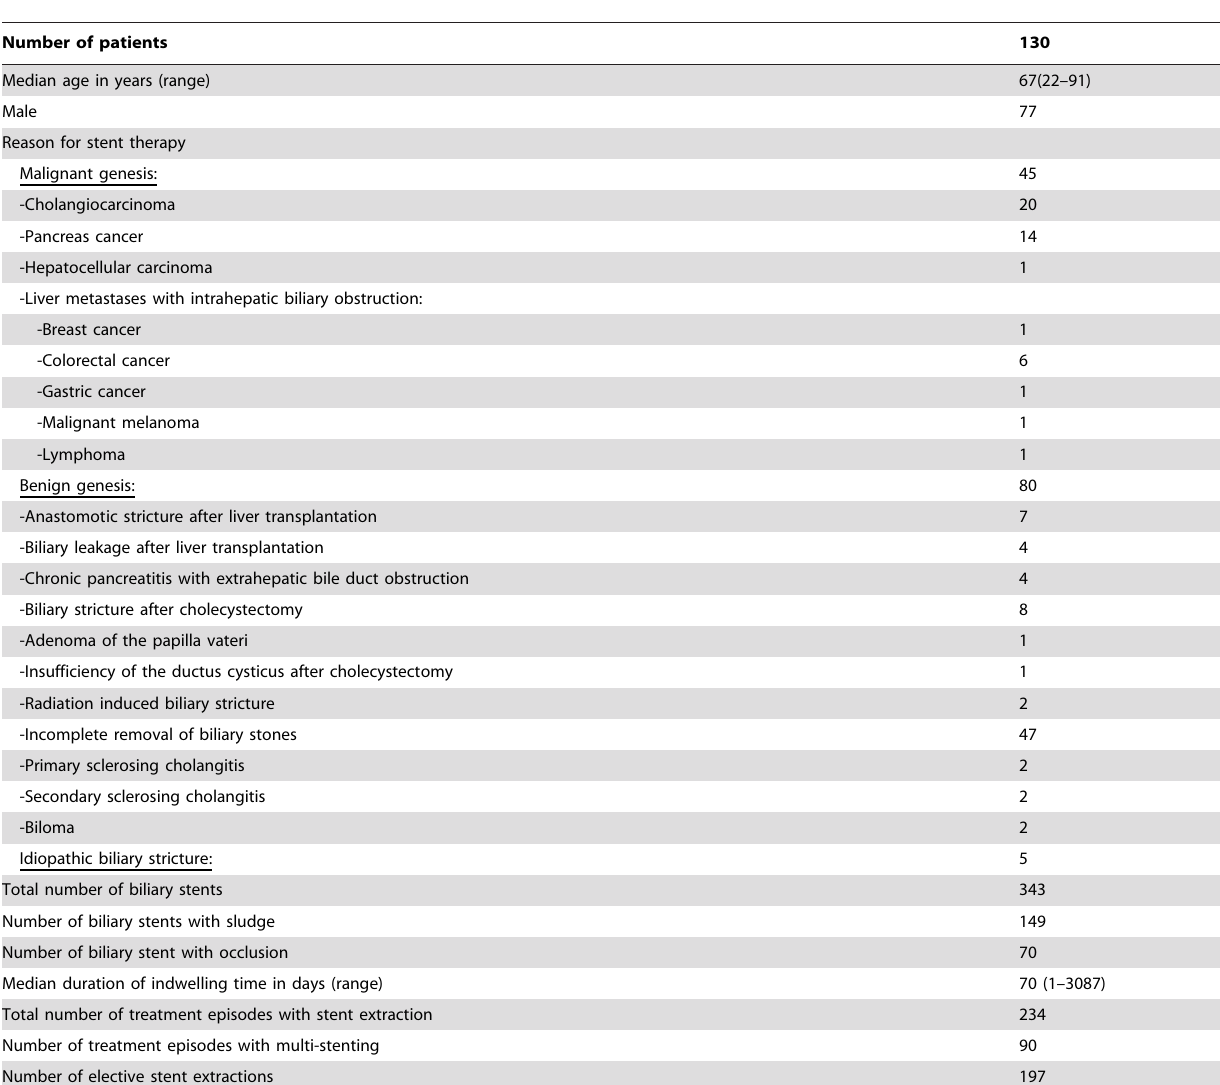
Table 1. Baseline